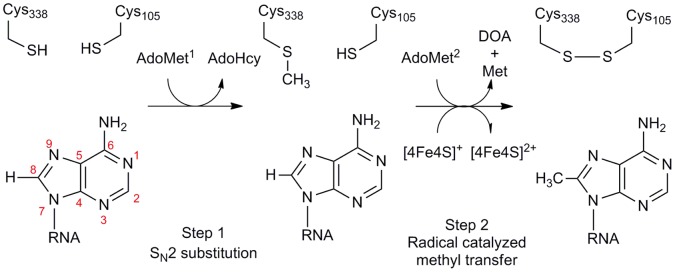
Utilisation of AdoMet by Cfr.Cfr consumes two AdoMet equivalents per reaction cycle to support both methyl transfer to Cfr Cys338 (AdoMet1; step 1) and subsequently generation of the 5′dA⋅ radical (AdoMet2; step2).